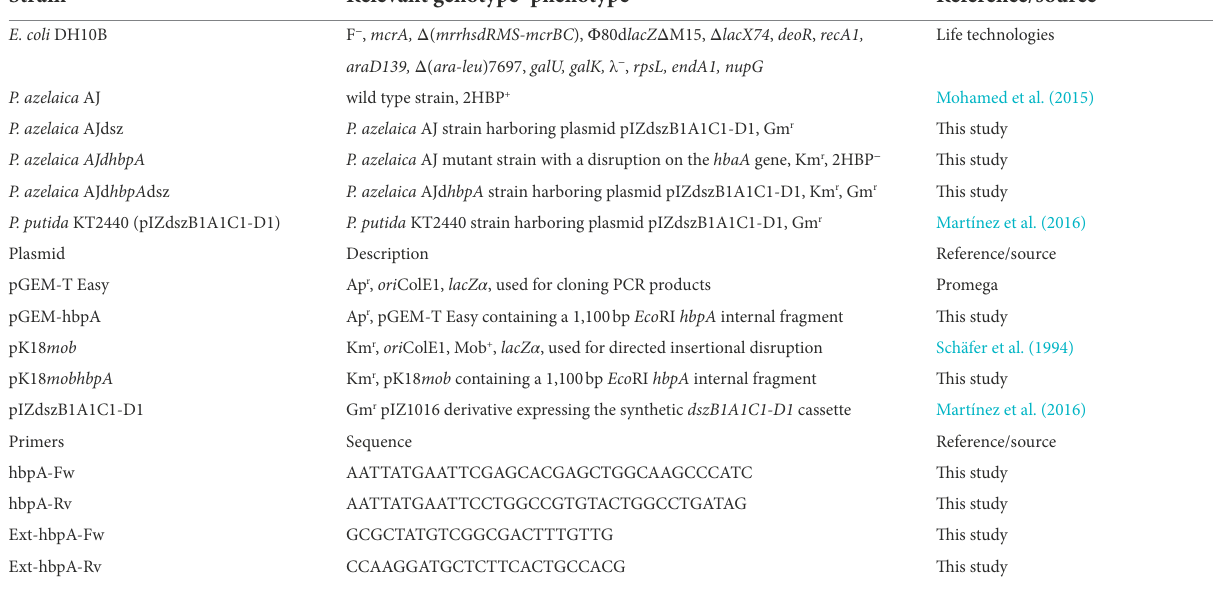
TABLE 1 Bacterial strains, plasmids and primers used in this